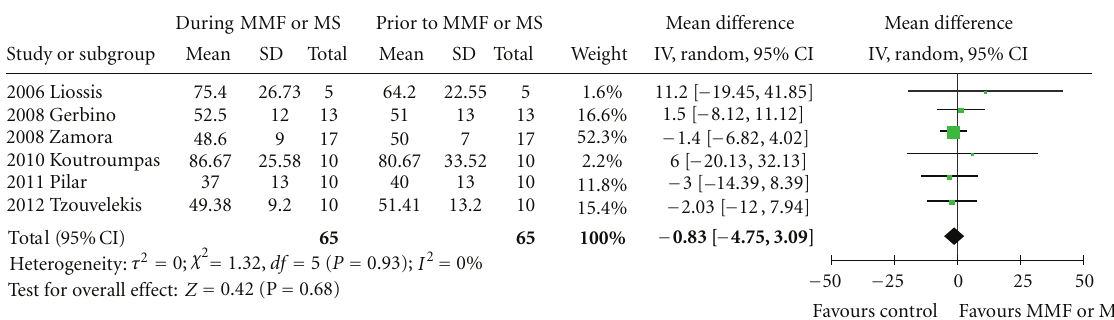
Figure 2: Forest plot of pooled data on DL CO prior (favours control arm) and during treatment with MMF or MS (favours MMF or MS arm). Abbreviations: CI: Confidence Interval, DL CO : Di ff using Capacity for carbon monoxide, MMF: Mycophenolate mofetil, MS: Mycophenolate Sodium, SD: Standard